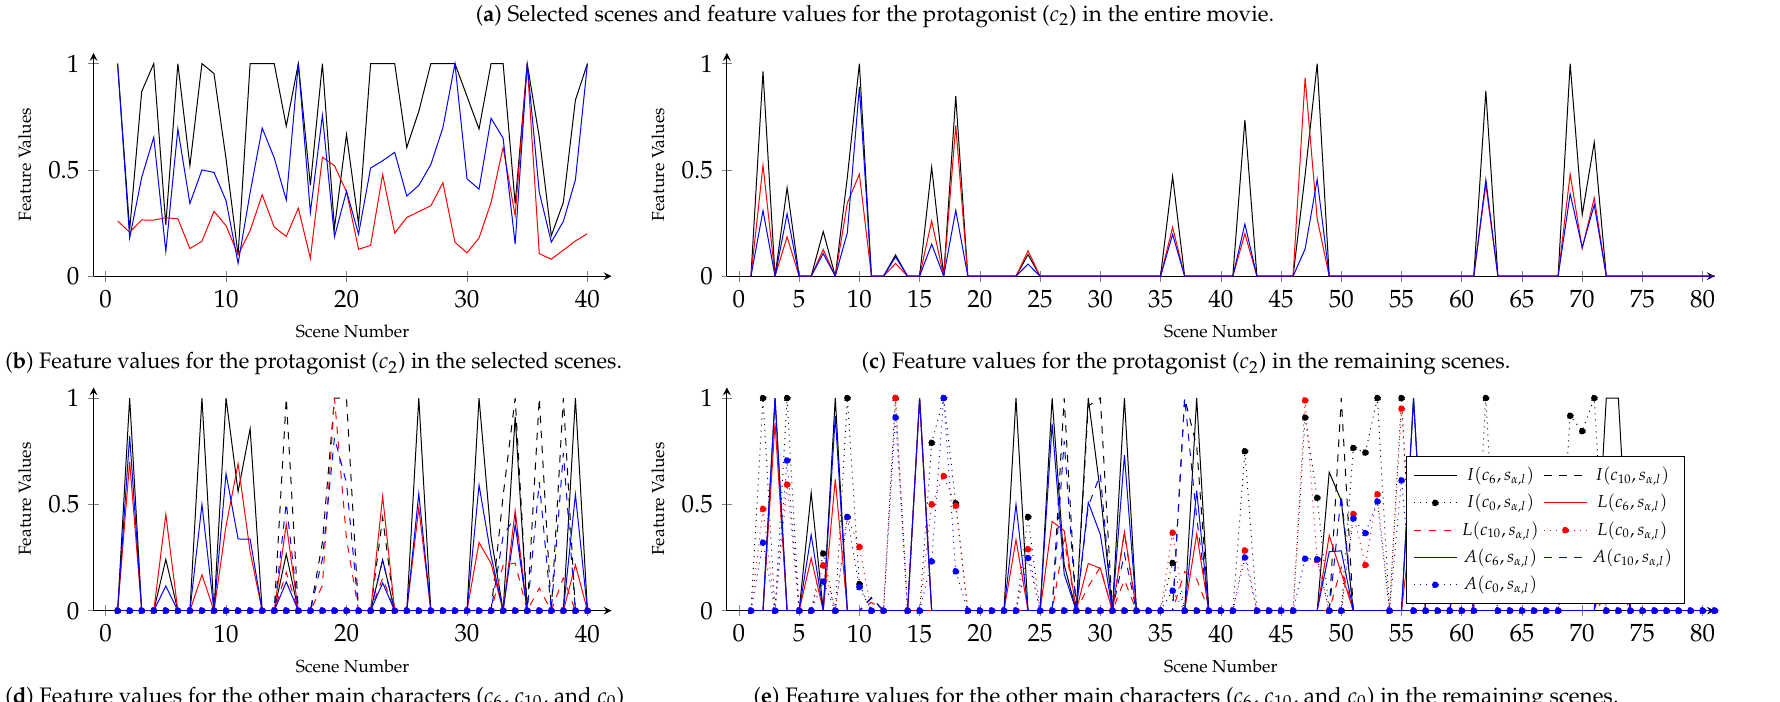
( e ) Feature values for the other main characters ( c 6 , c 10 , and c 0 ) in the remaining scenes. ( d ) Feature values for the other main characters ( c 6 , c 10 , and c 0 ) in the selected scenes. Figure 4. A story line discovered by the first iteration of the proposed decomposition method from ‘Good Will Hunting (1997).’ ( a ) presents feature values for the protagonist, ‘Will’ according to the narrative time. Gray areas indicate selected scenes as a part of the dominant story line. ( b , c ) present changes in the feature values for ‘Will’ in the selected and remaining scenes, respectively. ( d , e ) illustrate feature values for the other main characters (e.g., ‘Sean’, ‘Lambeau’, and ‘Chuckie’) in the selected and remaining scenes,